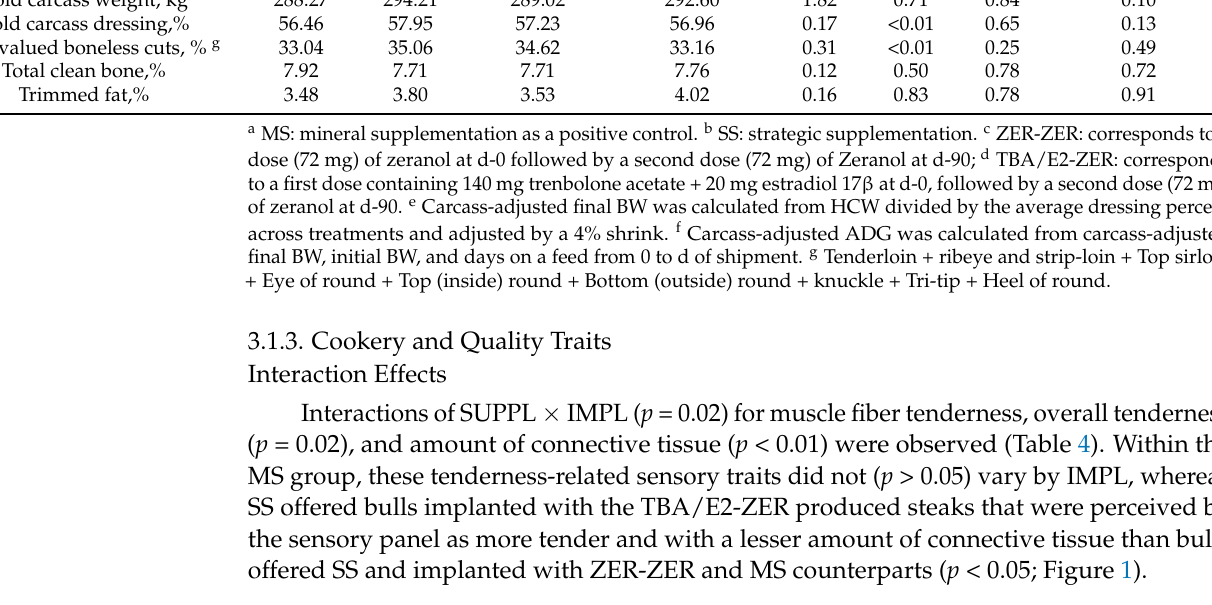
Table 4. Cookery traits, Warner–Bratzler shear force, and trained panel ratings of bull steaks according to supplementation and implant treatments (Experiment